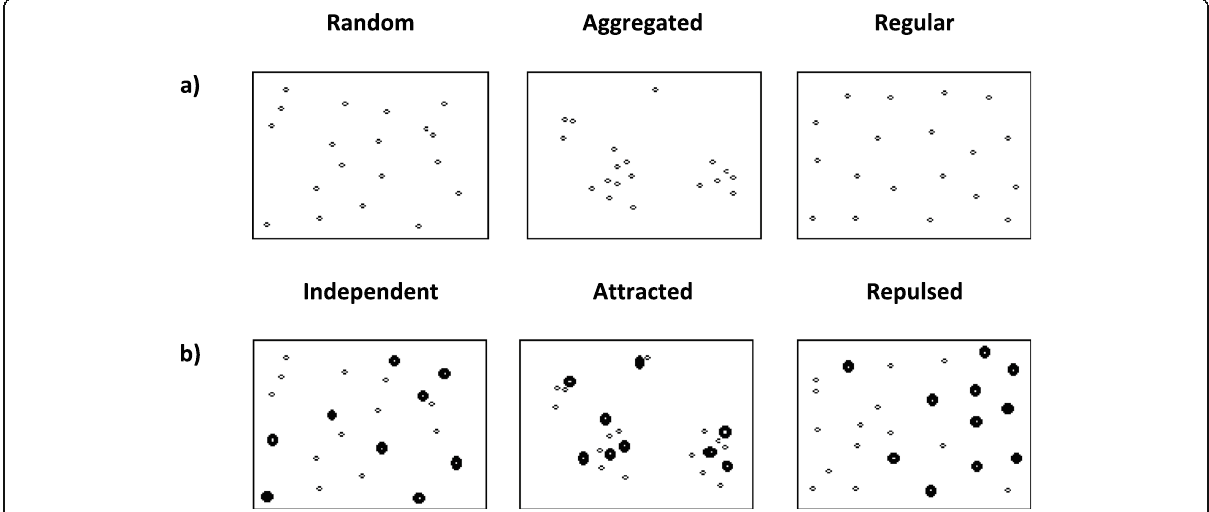
Fig. 2 Different patterns for one type of point ( a ) and two types of point ( b ). Randomness, aggregation, and regularity are commonly reserved to univariate analysis involving one pattern type, while independence, attraction, and repulsion are confined to bivariate